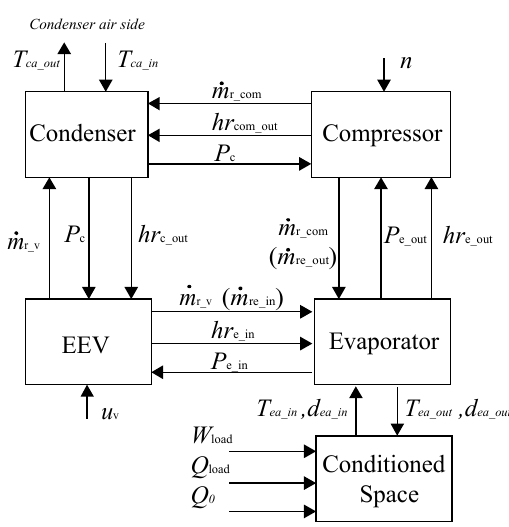
Figure 3. Coupling relationships among the sub-models.